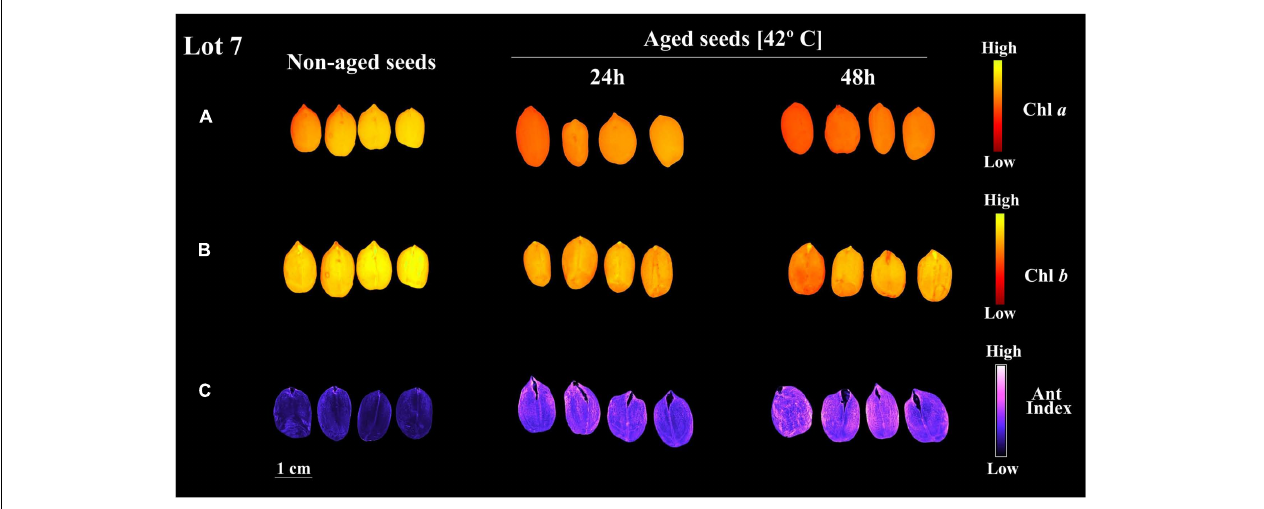
FIGURE 6 | Chlorophyll a fluorescence (Chl a ) at 630/700 nm excitation/emission combination (A) , chlorophyll b fluorescence (Chl b ) at 405/600 nm excitation/emission combination (B) , and anthocyanin index (Ant Index) (C) in peanut seeds ( Arachis hypogaea L.; cv. IAC OL3) from lot 7 for classes on non-aged seeds and seeds aged for 24 h and 48 h. Each pixel in the images is represented by a unique value that corresponds to chlorophyll a and b fluorescence intensity or anthocyanin level.